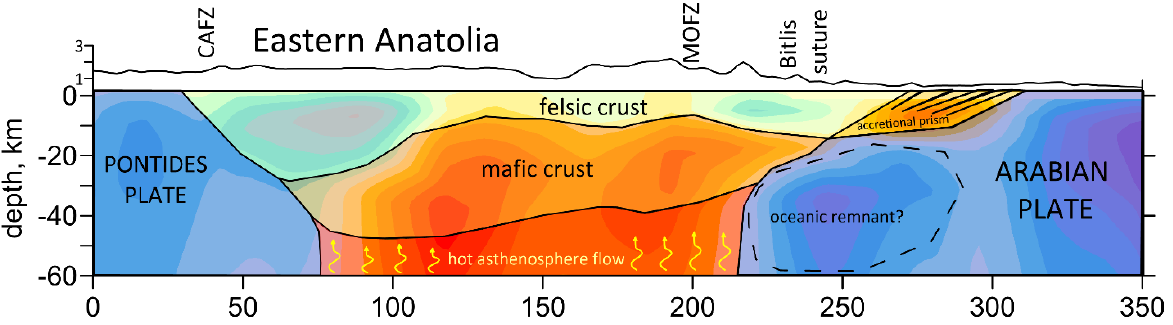
Figure 8. Scheme of the Crustal Structure along profile 1 under Eastern Anatolia.